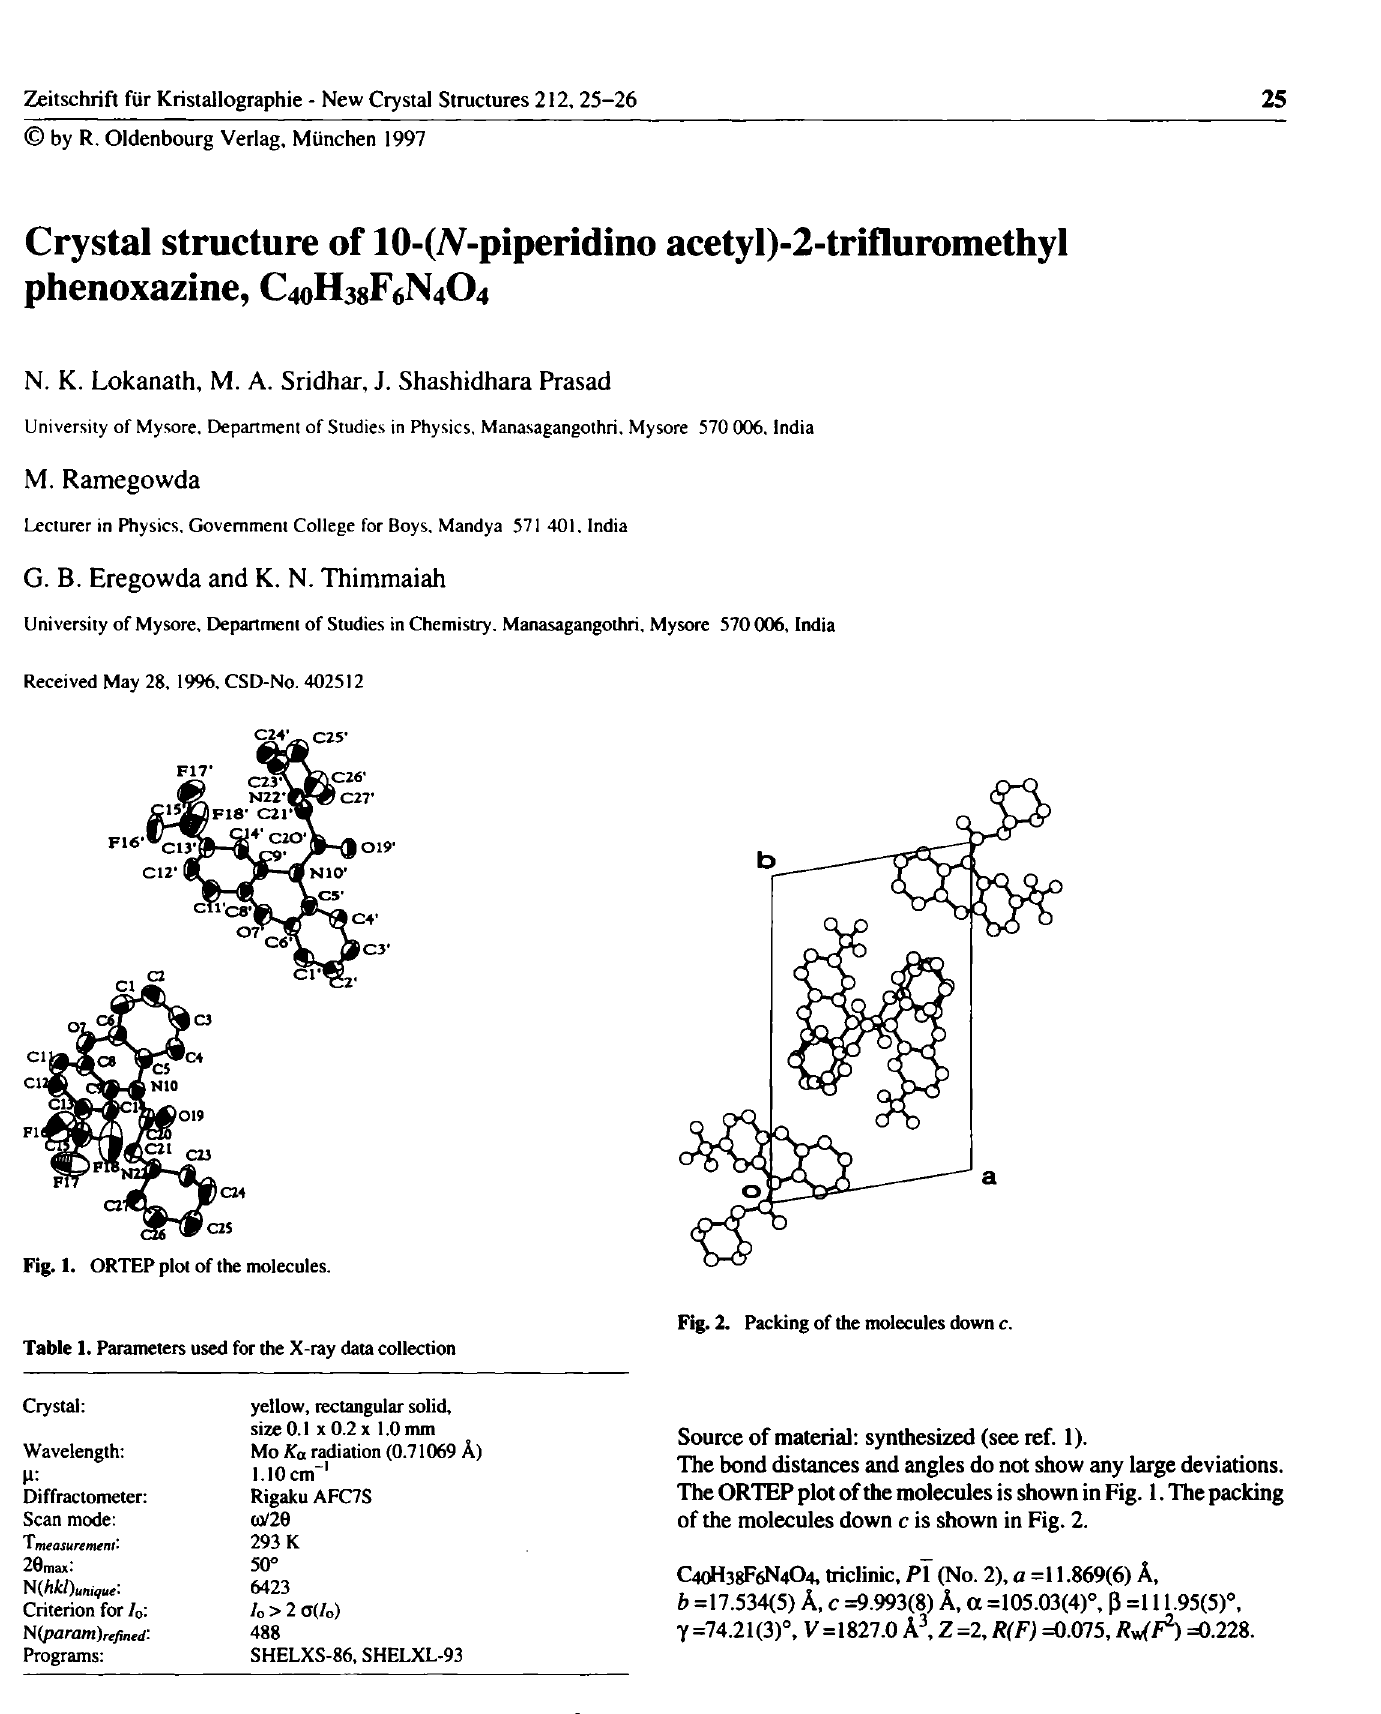
Table 1. Parameters used for the X-ray data collection